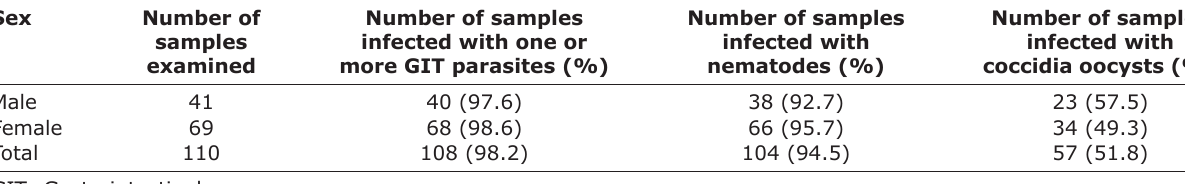
Table-5: Prevalence of gastrointestinal parasites by